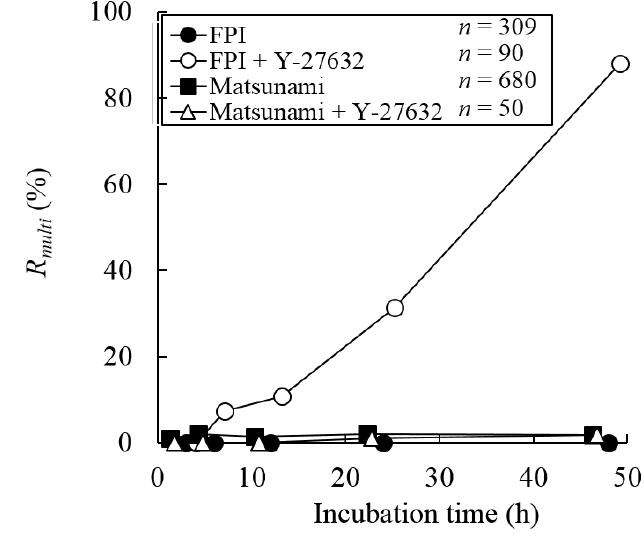
Figure 3. The percentage of multinucleated cells ( R multi , as defined in Equation (5)) of XTC-YF cells after seeding on less (FPI) and more hydrophilic (Matsunami) dishes and culture in the presence or absence of Y-27632. n , Number of